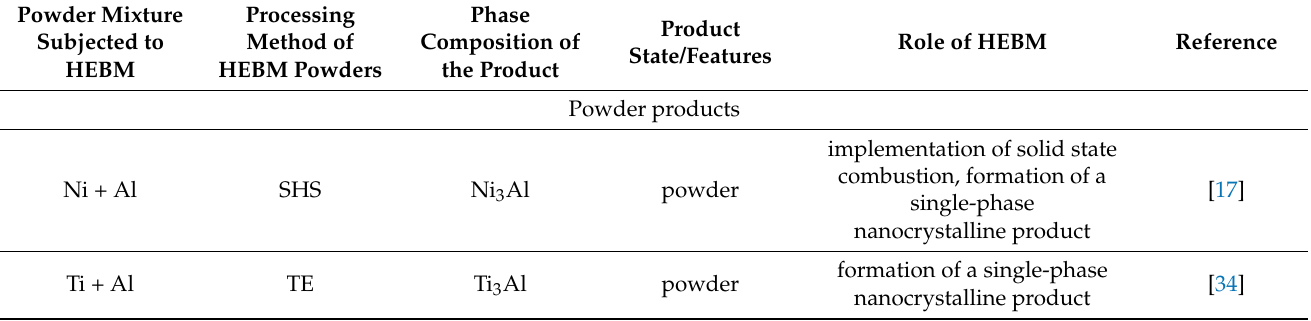
Table 1. Selected examples of ceramic, intermetallic, metallic alloy and composite products obtained from HEBM